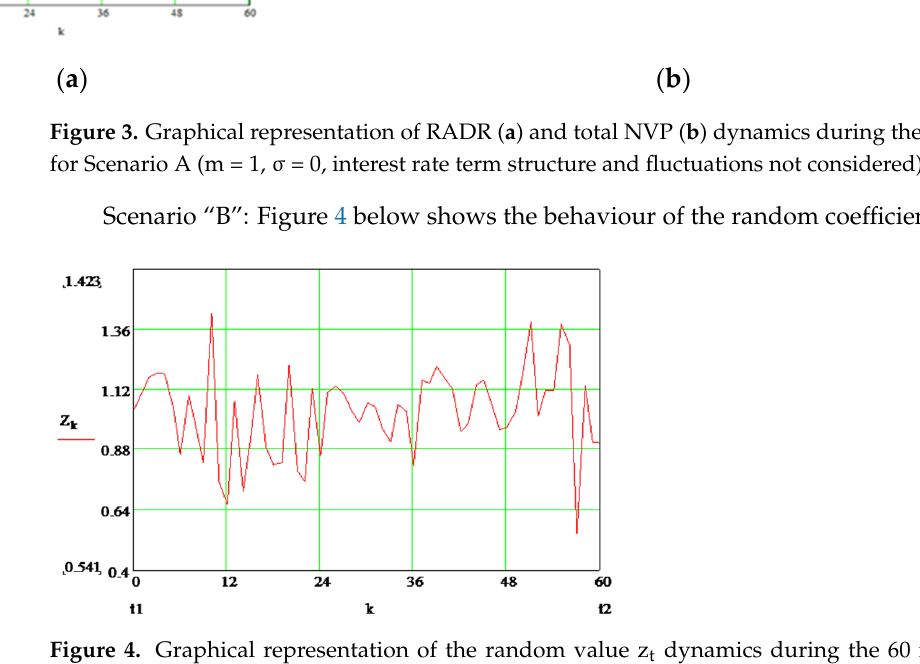
Figure 4. Graphical representation of the random value z t dynamics during the 60 months for Scenario B (m = 1, σ = 0.10, interest rate term structure and fluctuations not considered). Some details of the above scenarios are presented further. The RADR behaviour for all three companies of the group and the total NPV of their activity are illustrated in Figures 5–9.